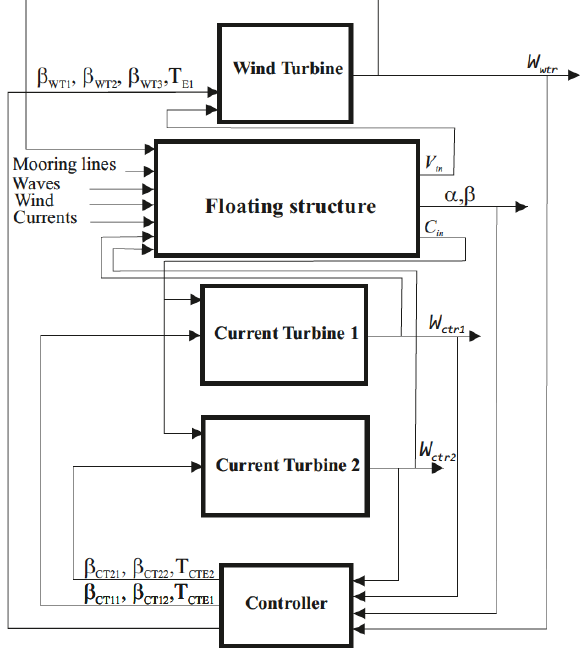
Figure 8. Control proposal of the integrated system.